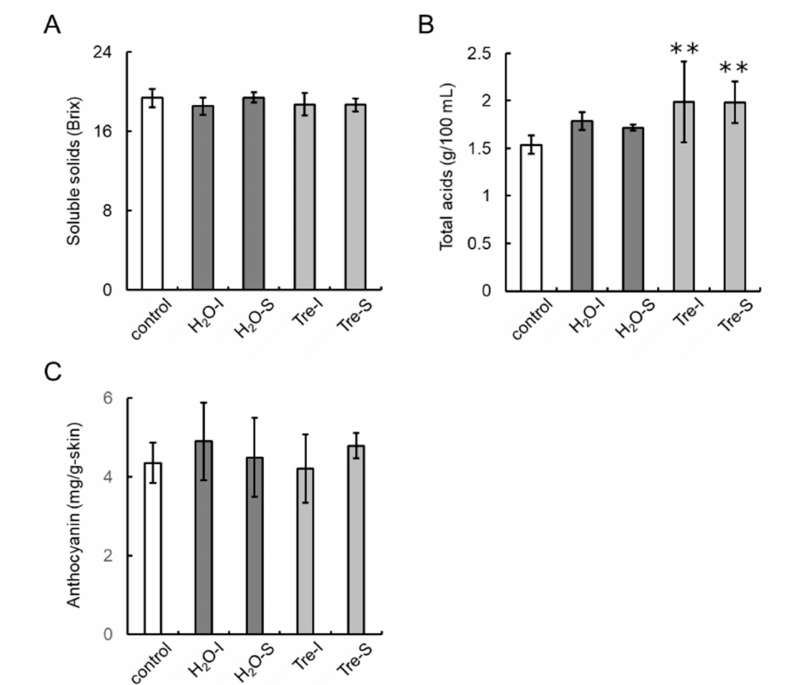
Figure 10. E ff ects of trehalose injection into buds nearing bud break on berry characteristics. Juices were obtained from each bunch (bunches are shown in Figure 8) by hand-pressing. Skins of ten berries from each bunch were peeled o ff with tweezers. ( A ) Soluble solids content. ( B ) Total acids content. ( C ) Anthocyanin content. Bars indicate means ± standard deviations of twenty bunches. ** p < 0.01 compared with control (Dunnett’s test). Control, non-treated grapevines. H 2